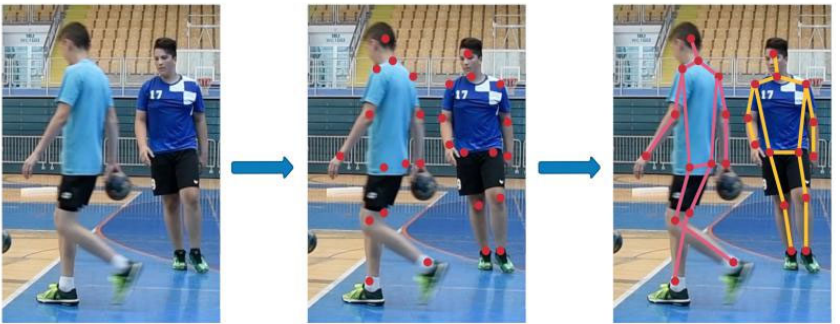
Figure 6. The bottom ‐ up pipeline in multi ‐ person approach for pose estimation. It starts by detecting all the keypoints in the image, which are then associated with human instances. all the keypoints in the image, which are then associated with human